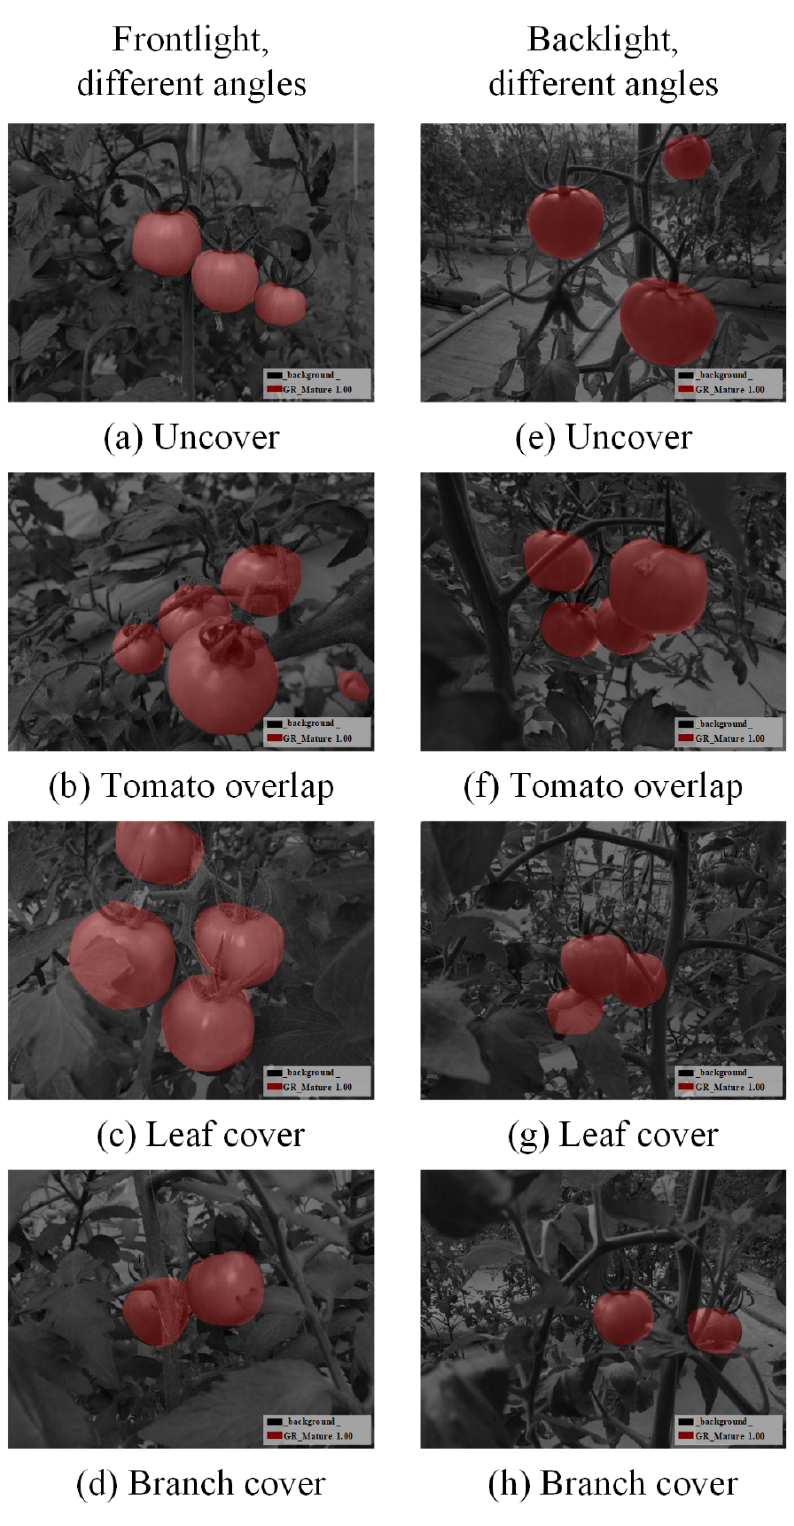
Figure 4. Visualization of manually annotated